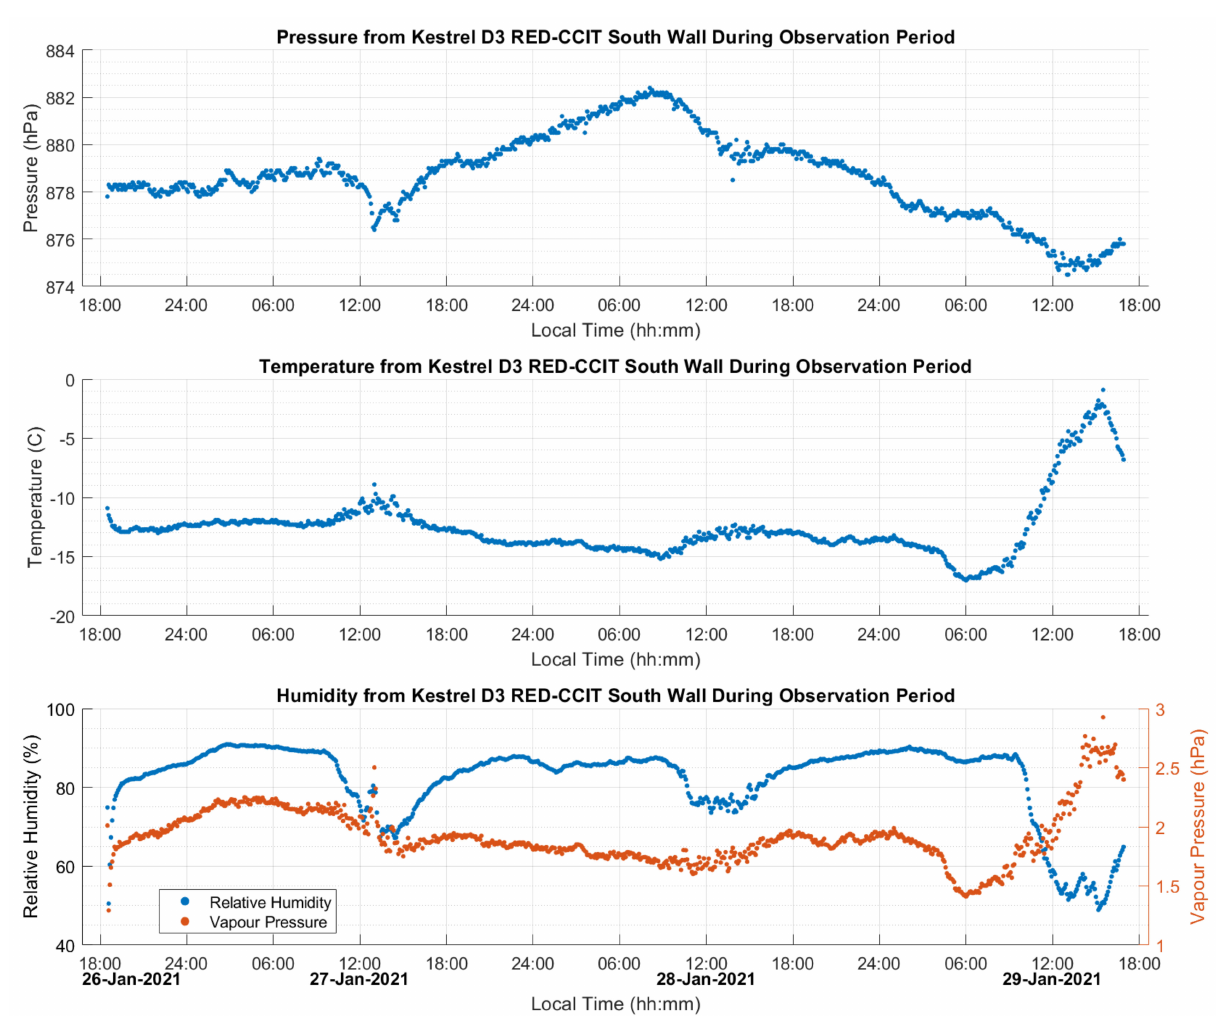
Figure 7. Static dataset A atmospheric conditions at test site (Elevation of 1135 m). Normal atmospheric pressure at 1135 m is 889.7 hPa. Local time is UTC −